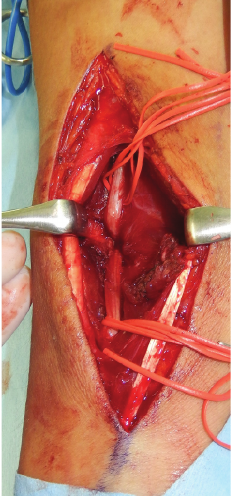
Figure 3: Intraoperative view of the entrapped median nerve at the fracture site of the